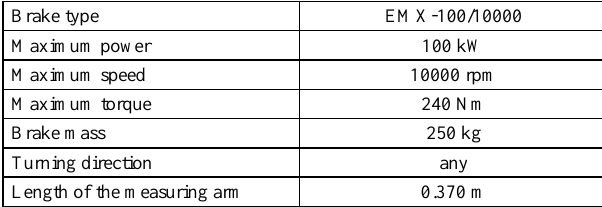
Table 1. Technical data of the EMX-100 brake